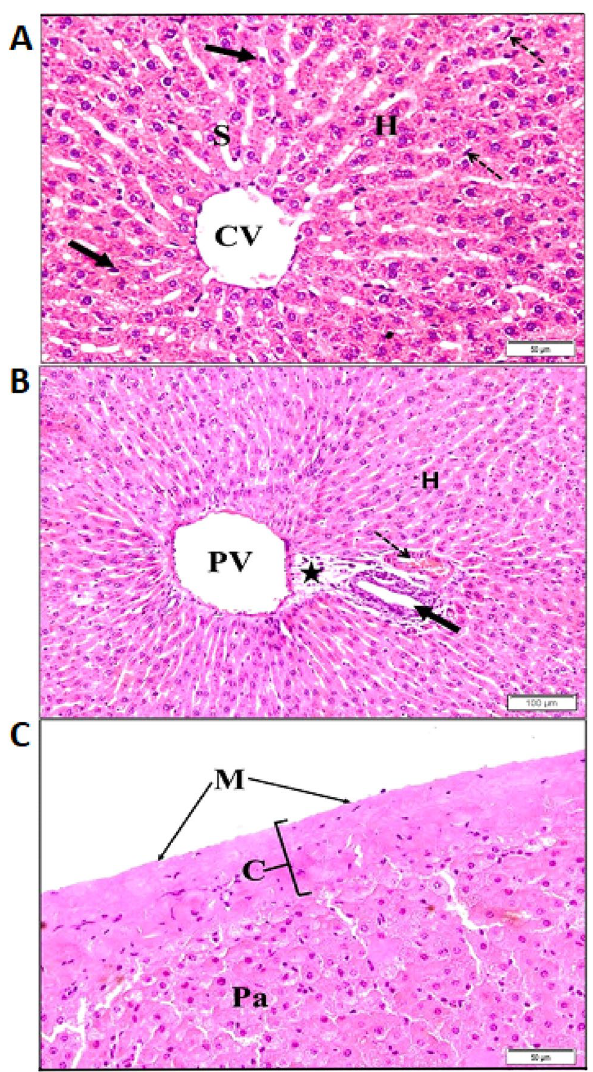
cells (arrows); ( B ) portal region with portal vein (PV), bile duct (black arrow) and hepatic artery (dotted arrow) with scanty connective tissues (black star). Note the normal feature of hepatocytes (H); ( C ) intact normal parenchyma (Pa) and normal thin Glisson’s fibrous capsule (C) covered by intact mesothelial cells